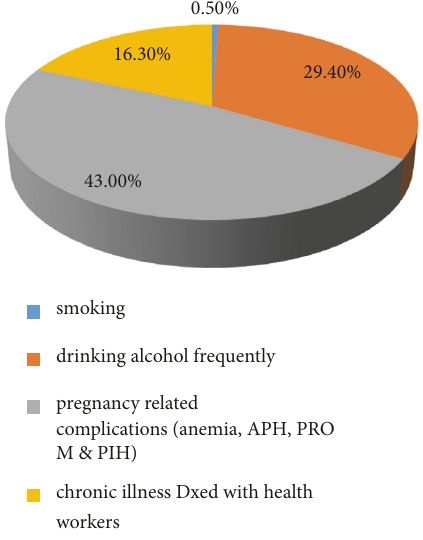
Figure 1: Health status of mothers who delivered at Dangla Primary Hospital, Awi Zone, Amhara Region, Northwest Ethiopia, 2017